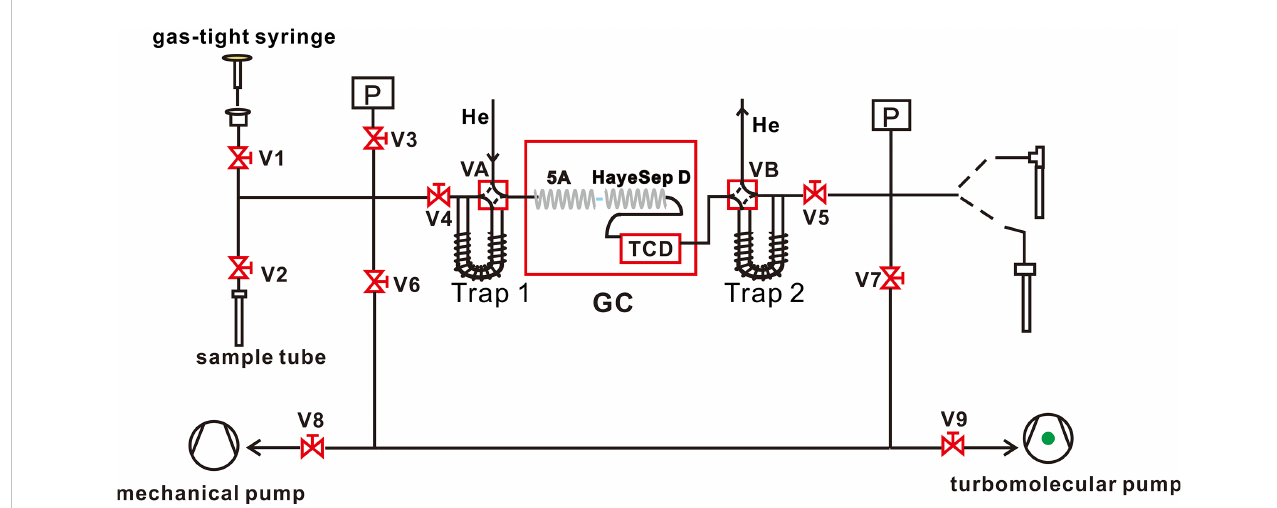
FIGURE 1 Schematic diagram of the puri fi cation system. The alphabet P represents pressure-vacuum gauge. The alphabet V represents valve, for example, V1 represents a two-way valve numbered 1; VA represents a four-way numbered A. The GC represents gas chromatography. The TCD represents thermal conductivity detector. The 5A represents 5A molecular sieve. The HayeSep D represents HayeSep D porous polymer. The black lines wrapped Trap represent heating strips.